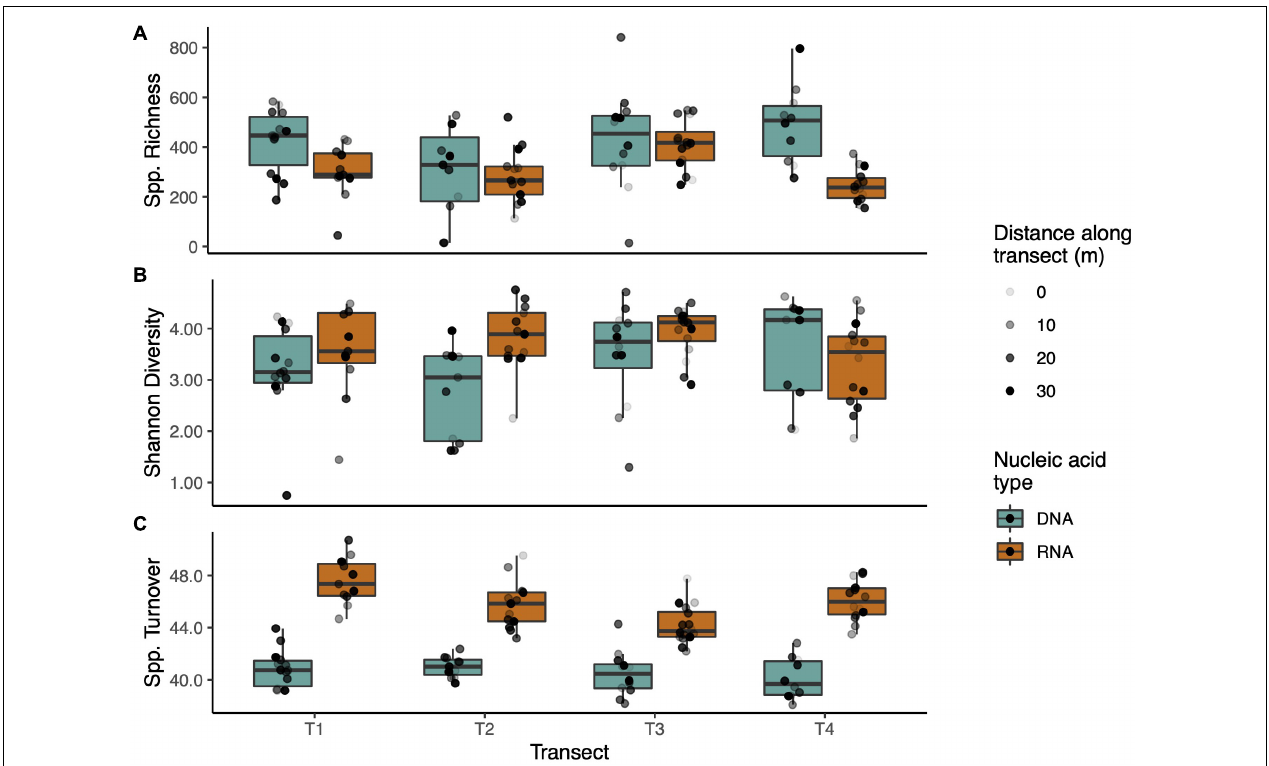
FIGURE 3 | Alpha and beta diversity of transects. (A) Transects did not differ significantly in species richness, though DNA communities generally captured greater richness. (B) Shannon diversity was consistent among transects and nucleic acid types. (C) Species turnover (beta diversity) was much higher in RNA communities than DNA communities. Boxplots span the 25th to 75th percentile with median values marked with the horizontal line. Whiskers depict at maximum ± 1.5 times the IQR from the lower hinge. Points are scattered individual data points shaded by distance along the